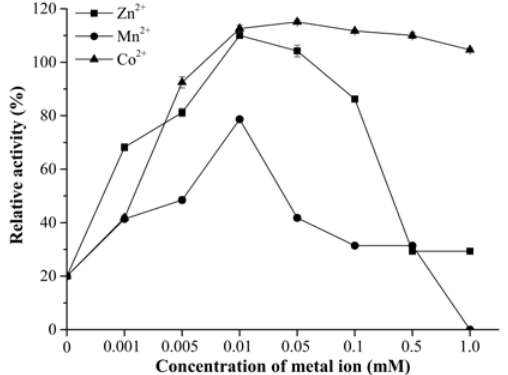
Figure 4. Reactivation of EDTA inhibited activity of Co DPP III via metal ions.